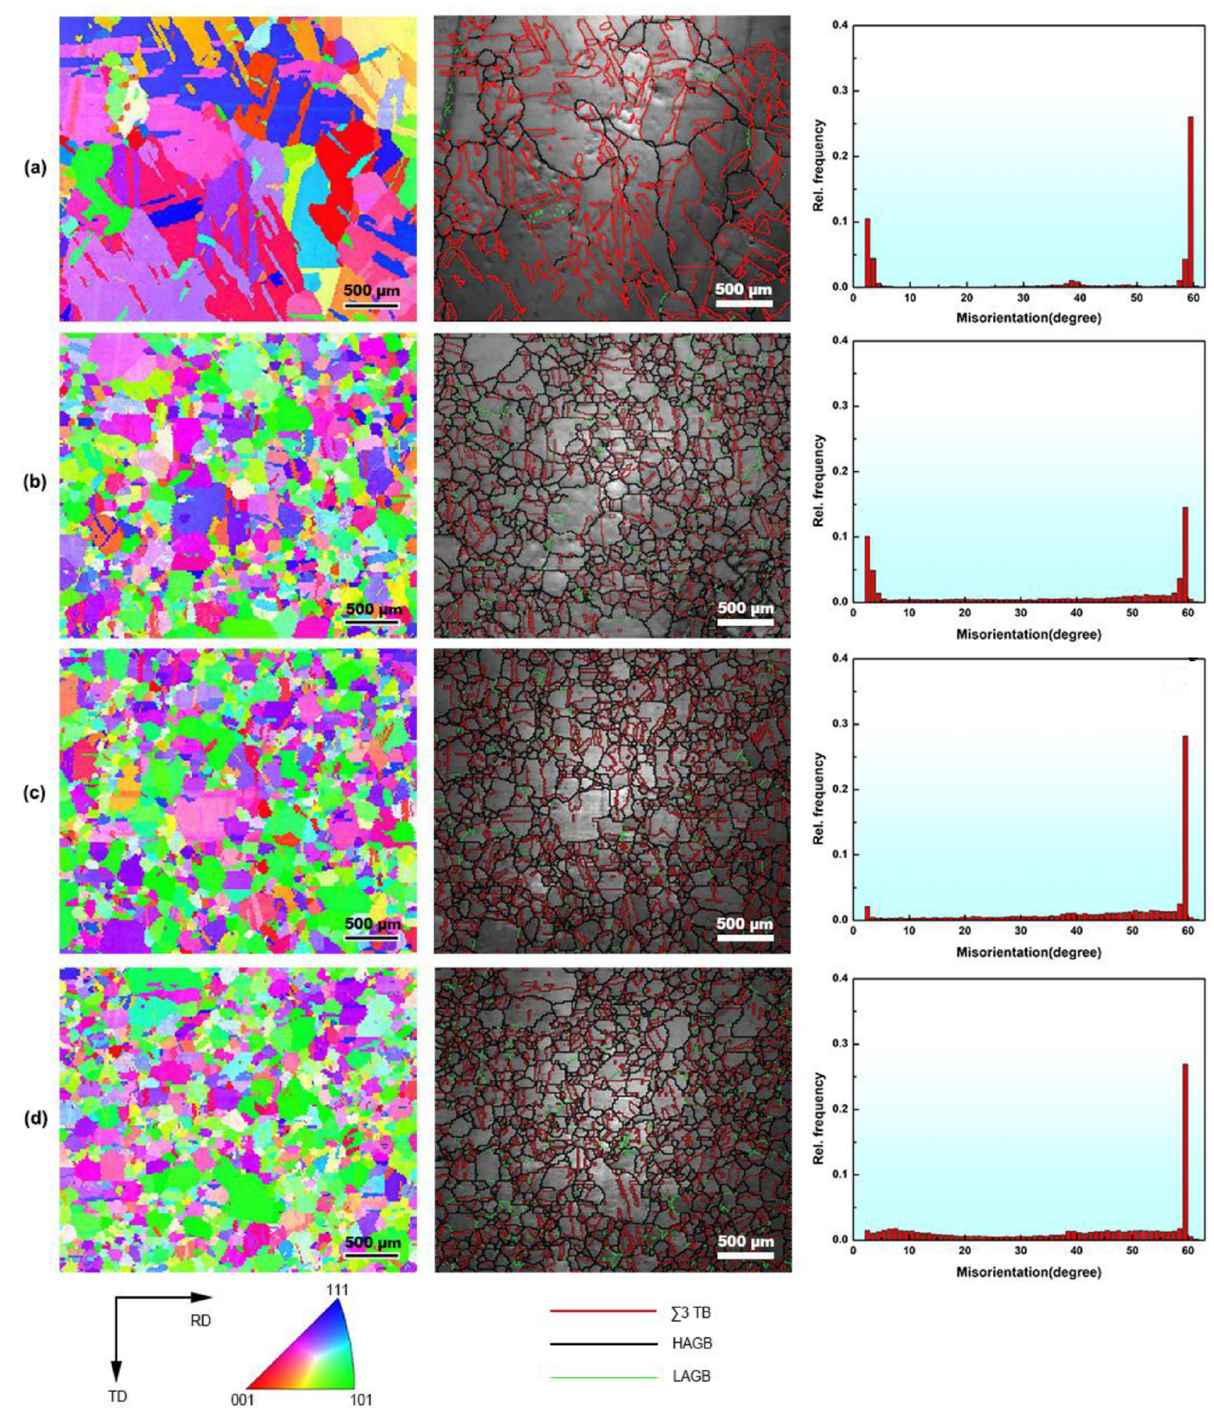
Figure 3. Orientation maps, corresponding grain boundary maps and misorientation histograms of the Cu specimens intermediate annealed at 500 °C for 5 min, ( a ) pure Cu, ( b ) P23, ( c ) P52, ( d ) P100, respectively.